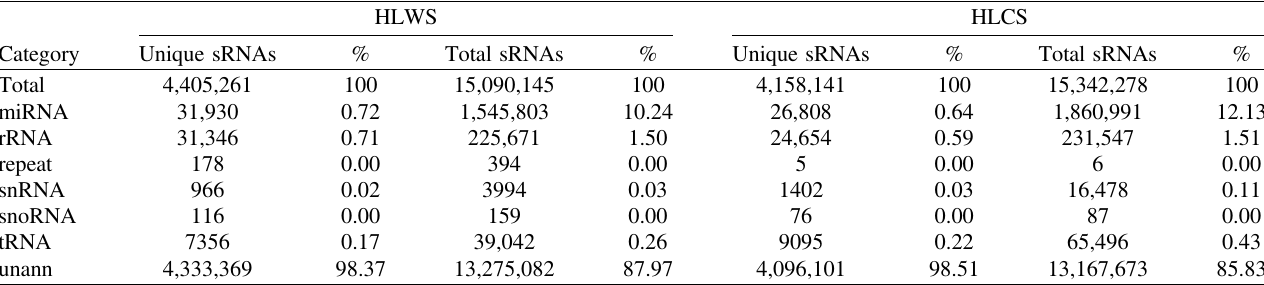
Table 1. Distribution of small RNAs among different categories.